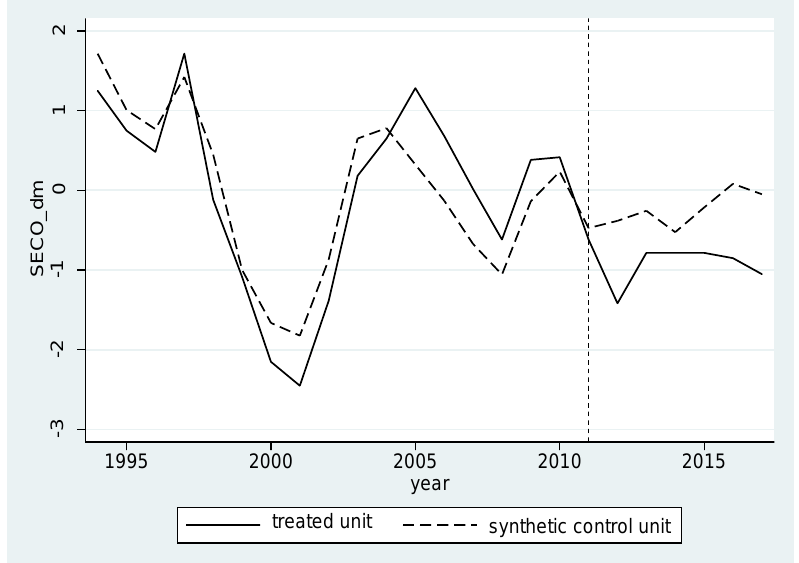
Figure 5. Outcome for Geneva: Demeaned SC and unemployment rate, including all pre-treatment variables as predictors.